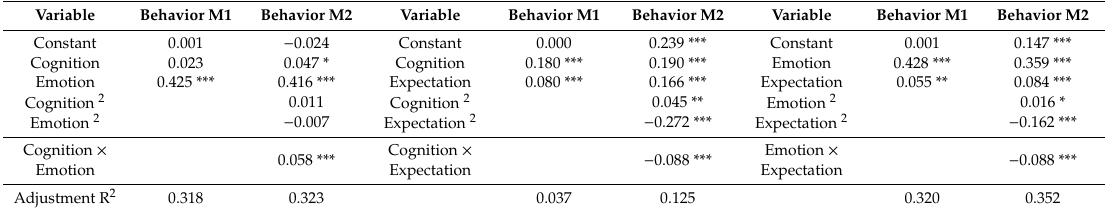
Table 4. Regression analysis on public occupational safety and health psychological